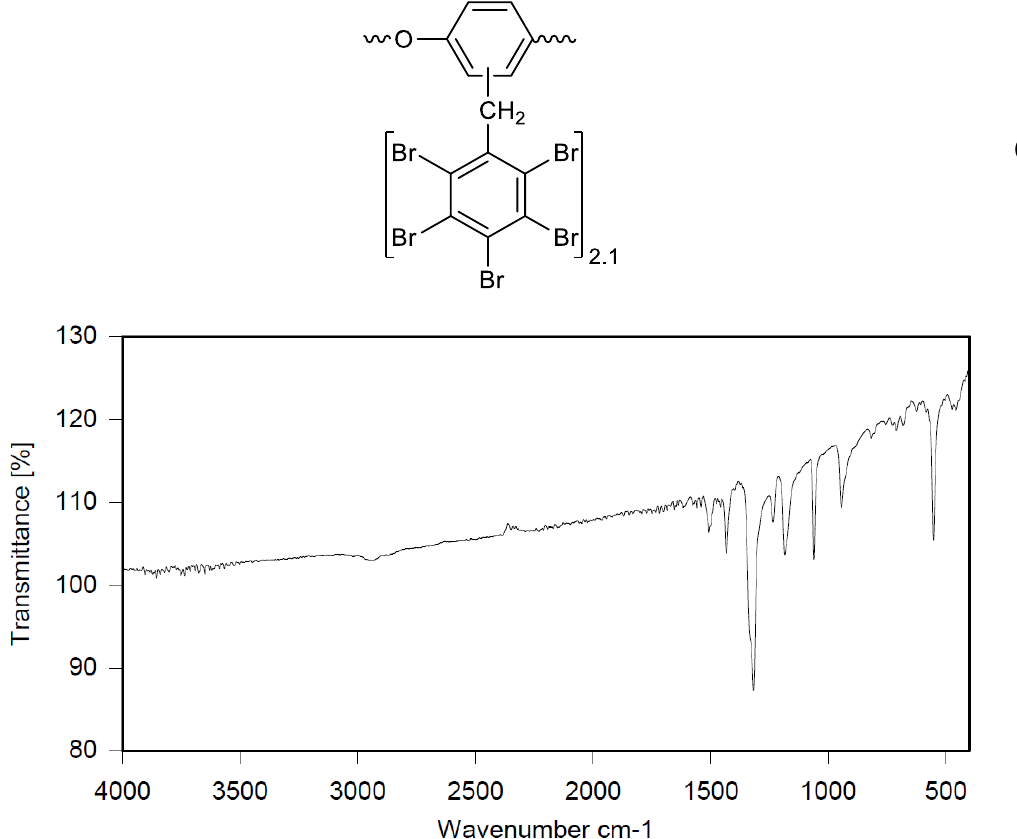
Figure 5. FTIR spectrum of polyphenylene ether alkylated with PBBB (PPE-PBBB).